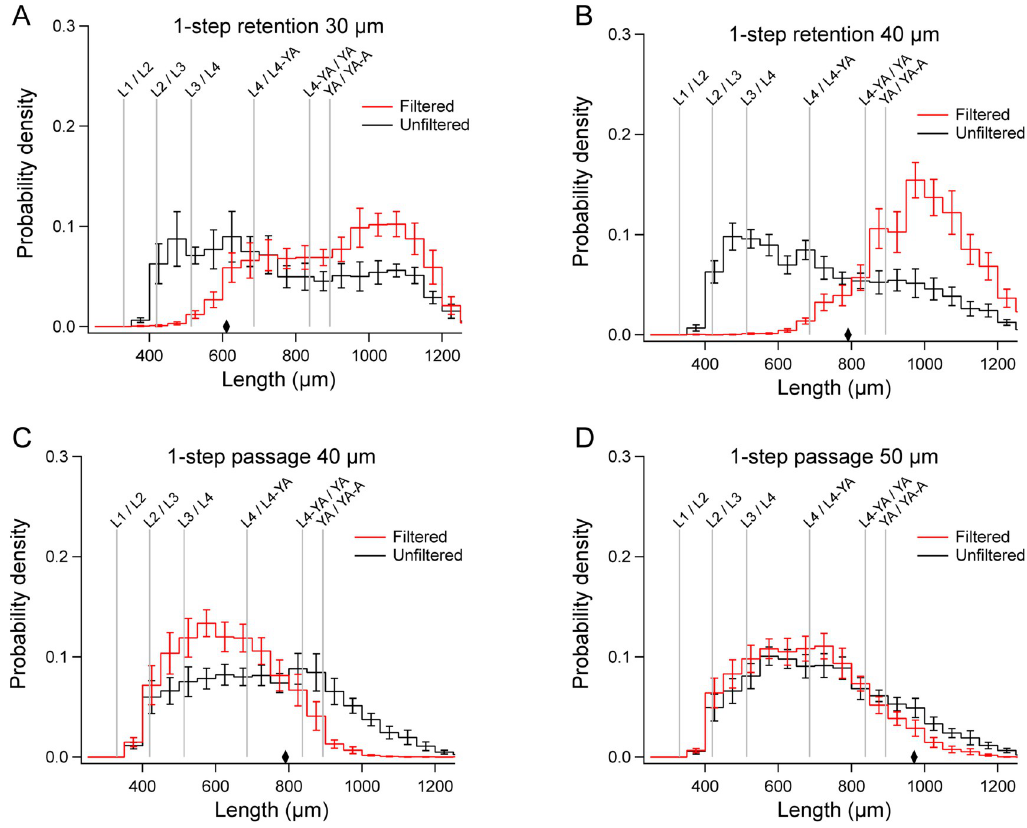
Fig 3. Mean distributions of filtered and unfiltered worms in 1-step filtration experiments. A-D. Mean filtered distributions, ð l Þ ( red traces ) and mean unfiltered distributions, H H f diameter equal to the mesh size. Error bars, SEM.